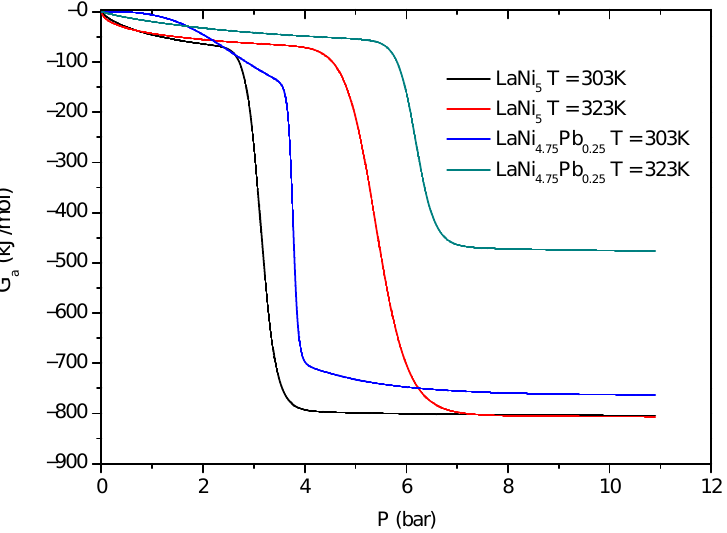
much more spontaneous.